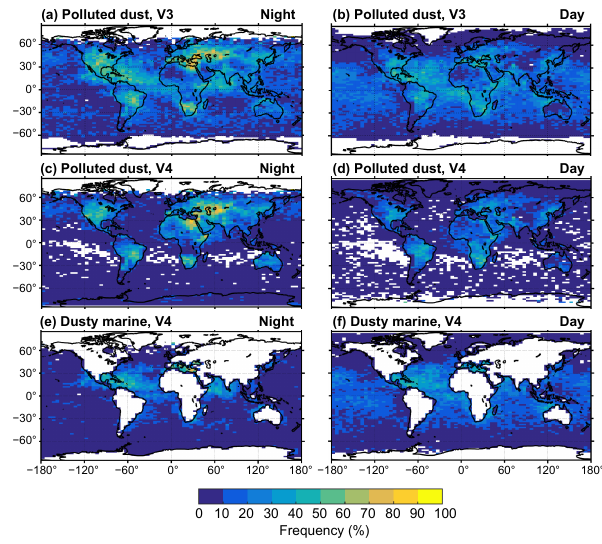
Figure 2. Frequency of occurrence of aerosol samples classified as polluted dust in V3 at night and during the day (a, b) , polluted dust in V4 at night and during the day (c, d) and dusty marine in V4 at night and during the day (e, f) . June–August